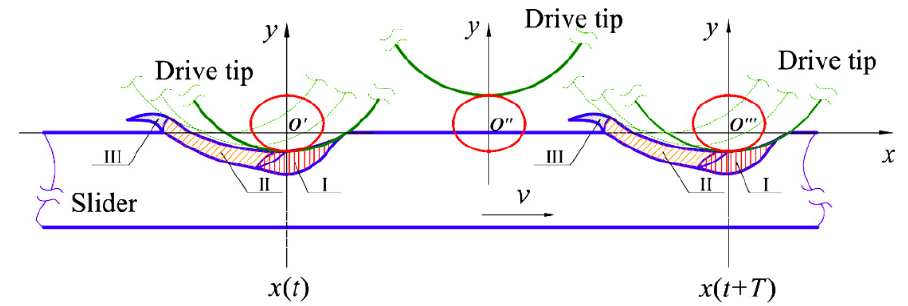
Figure 9. Periodical contact of the cylindrical driving tip and the slider, including three types of contact zones consisting of: (I) impact; (II) rolling; and (III) plastic deformation.